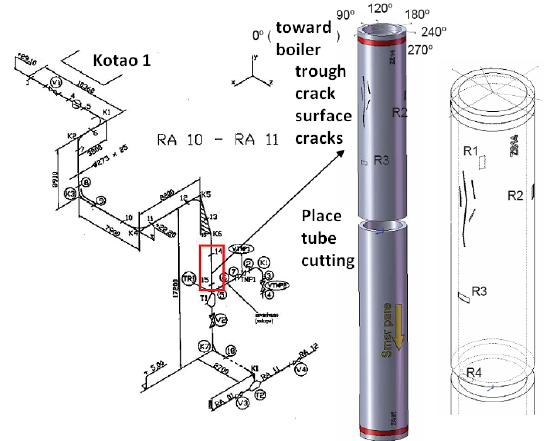
Figure 7: Scheme of measuring and making replicas of the damaged steam line part